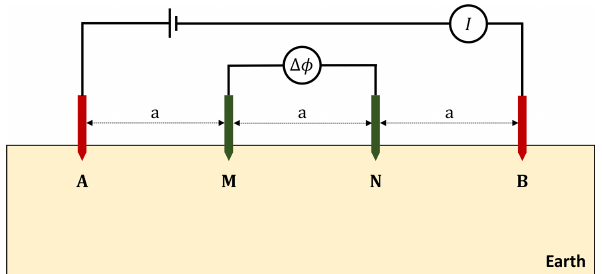
Figure 2. Wenner electrode configuration: four electrodes A, B, M, and N are deployed in-line with an equal spacing a between the two neighboring electrodes. Electrodes A and B act as the source and sink electrodes where current I is injected, while electrodes M and N act as the receiving electrodes measuring a potential difference (cid:49)φ